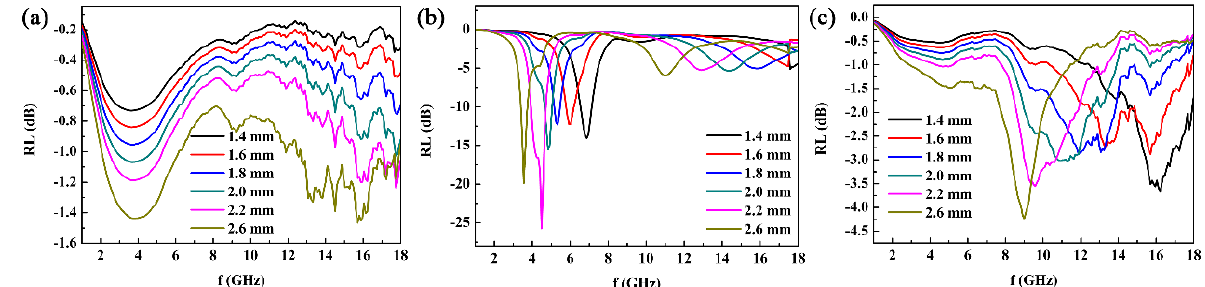
Figure 9. ( a ) The 𝑅𝐿 − 𝑓 curves of the Fe 3 O 4 /paraffin sample, ( b ) 𝑅𝐿 − 𝑓 curves of the Co/paraffin sample, and ( c ) 𝑅𝐿 − 𝑓 curves of the Co/Fe 3 O 4 /paraffin sample.